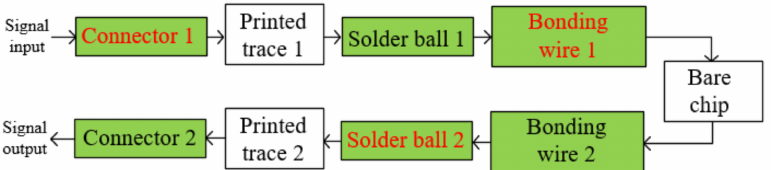
Figure 9. Signal transmission path. M1 represents that connector 1 is faulty. M2 represents that bonding wire 1 is faulty. M3 represents that solder ball 2 is faulty.